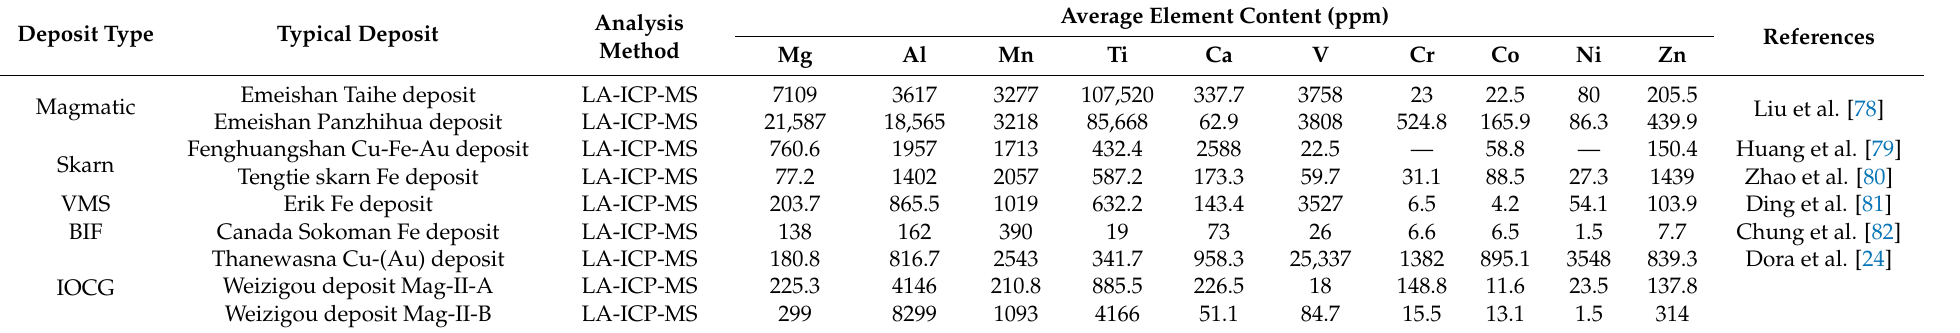
Table 6. Trace element contents of magnetite in different types of